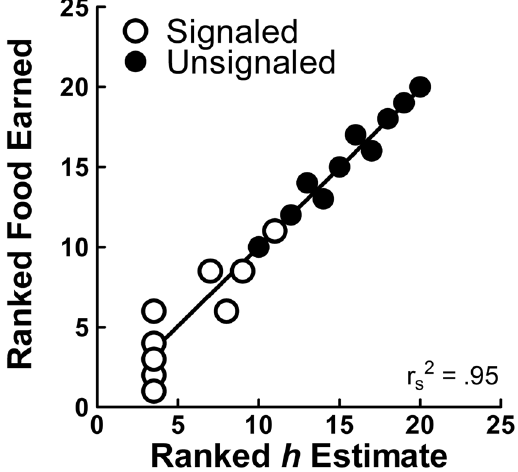
Figure 4. Spearman correlation of the cumulatively ranked obtained rewards for all birds in the signaled and unsignaled conditions as a function of ranked discounting estimates (parameter h ; n = 20).